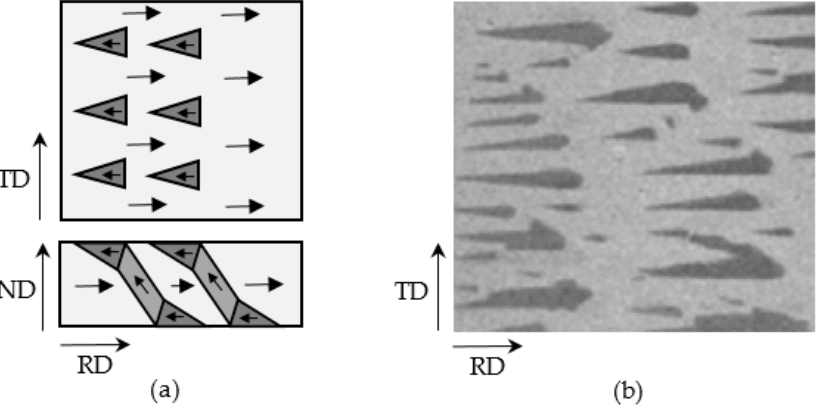
Figure 5. Lancet domains for GOES. ( a ) Sketch of the typical lancet domain orientation around the grain boundaries; ( b ) image of the lancet domains of a (110)[001] FeSi sample [47] (p. 3577).